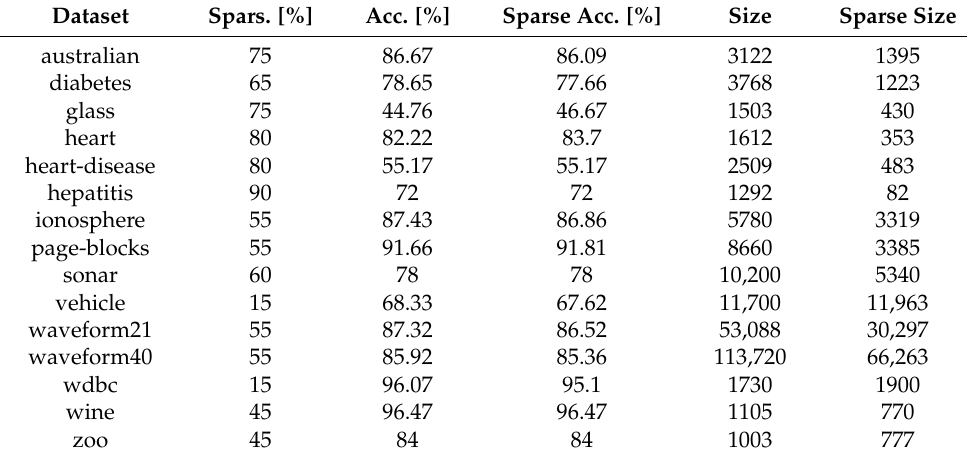
Table 3. Sparse SVM predictive model